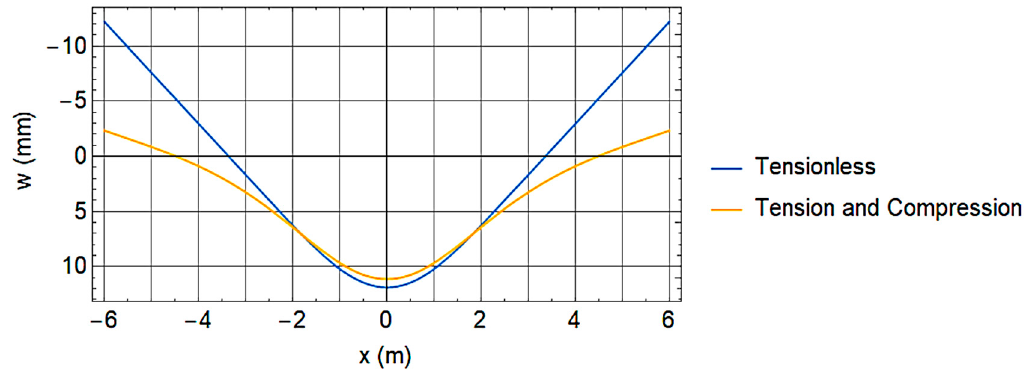
Figure 7. The deflection results for the symmetric case (X = 2L/5 )